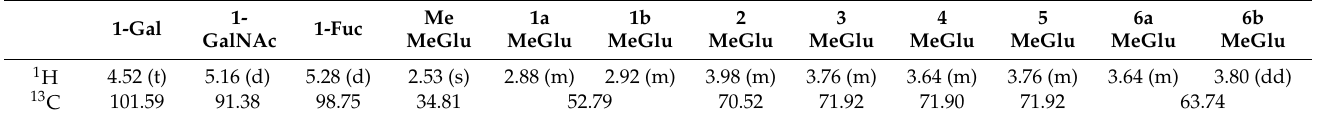
Table 1. 1 H- and 13 C-NMR assignment for conjugate (Selected peaks, 600 MHz, D 2 O).